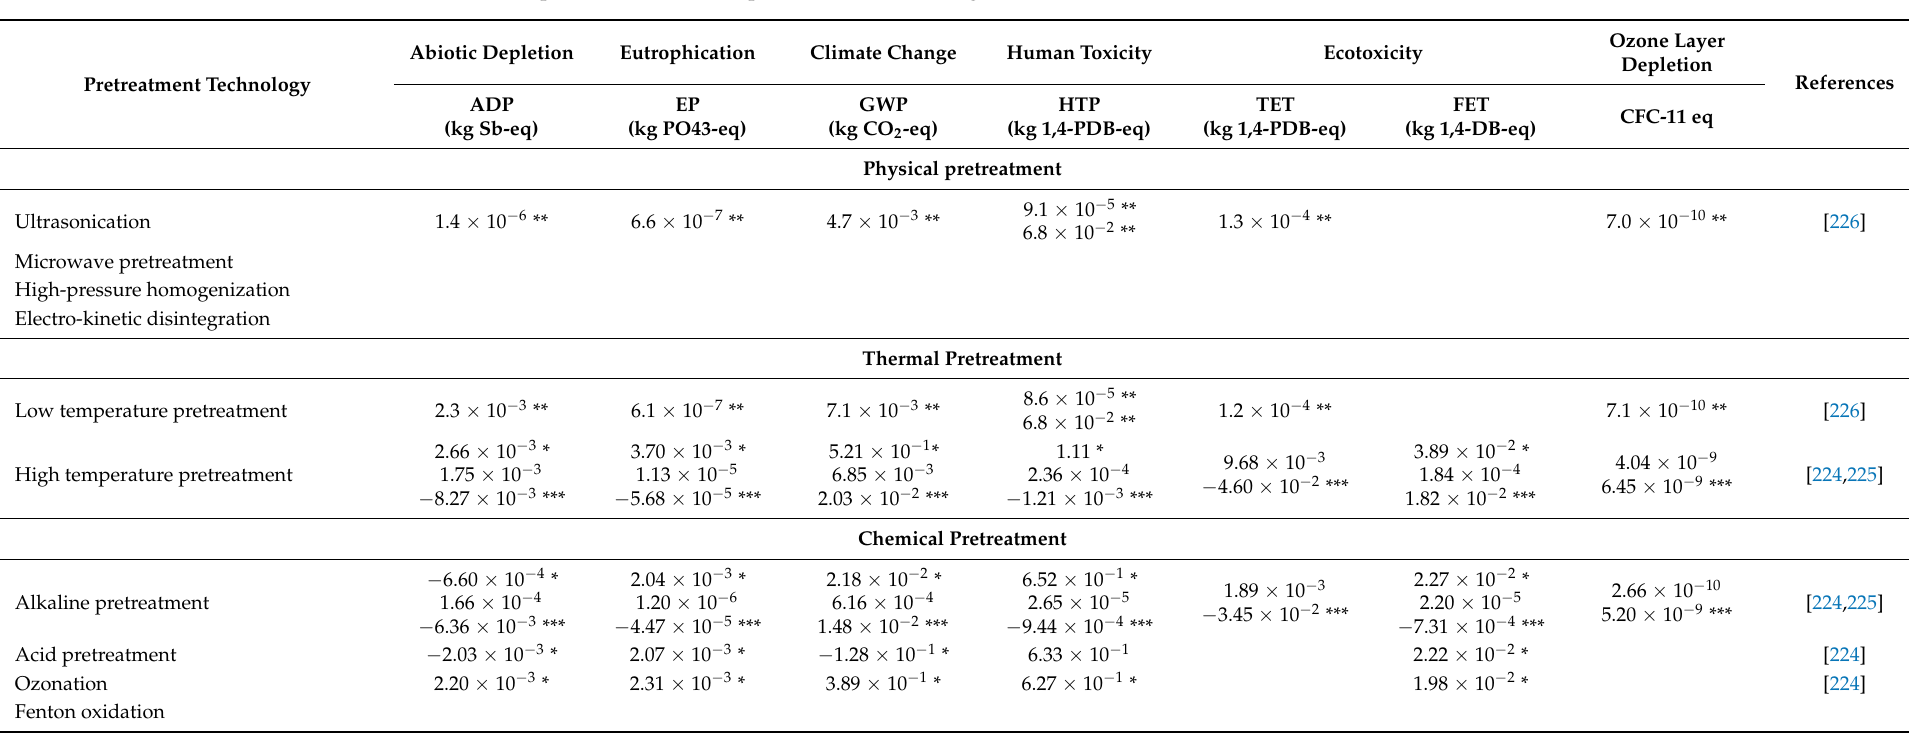
Table A1. Relative impact of most studied pretreatment